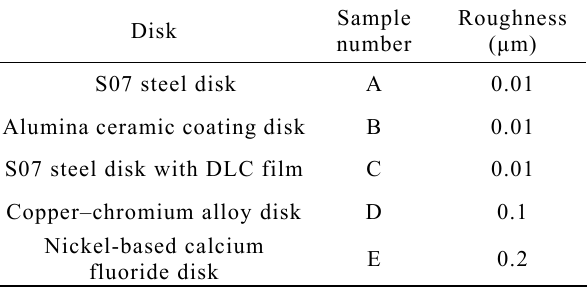
Surface roughness of the disks.